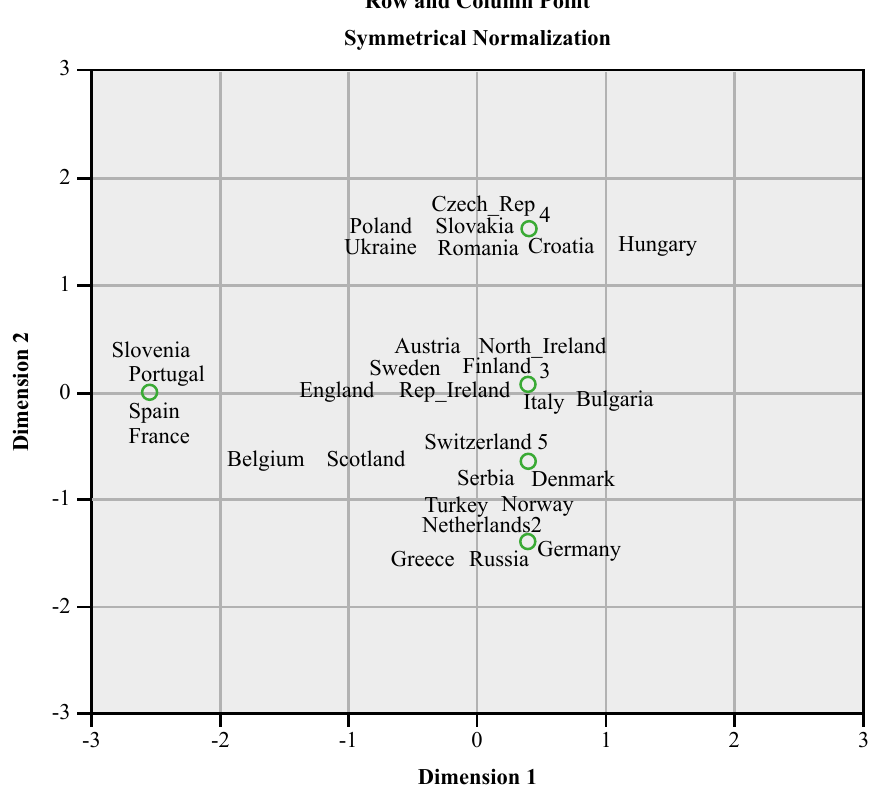
Figure 3: Countries representation in each Cluster using Correspondence Analysis.